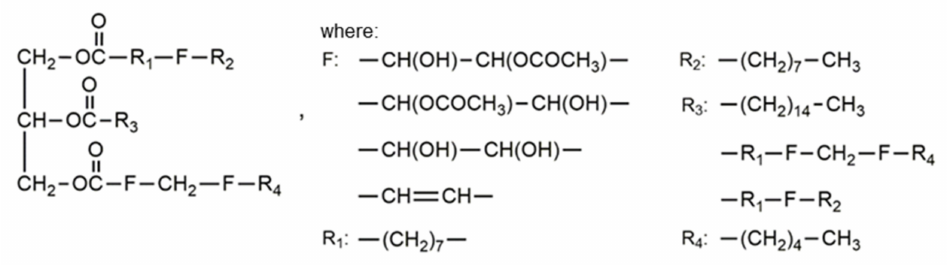
Figure 4. General structures of primary polyols obtained from vegetable oils.